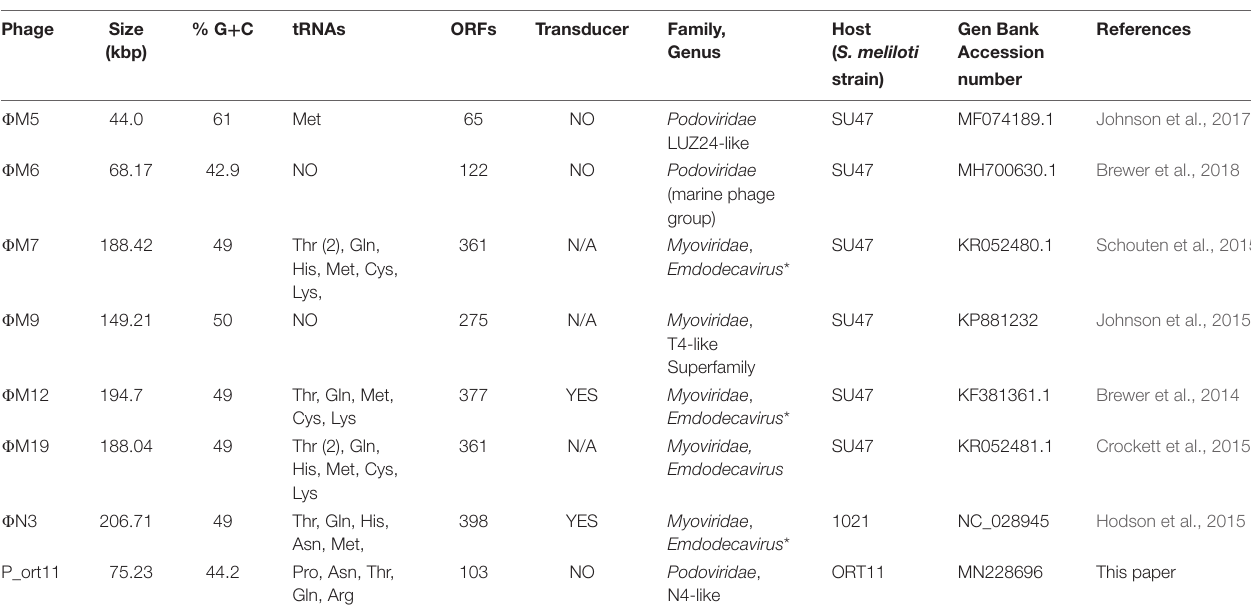
FIGURE 5 | Phylogenetic analysis of vRNAP (A) and terminase large subunit (B) proteins of P_ort11 compared to other N4-like phages. Neighbor-joining tree was constructed based on ClustalW (MEGA5). Bootstrap values ( > 50 %) are expressed as percentages of 1,000 replicates. Bar, 0.05 amino acid substitutions per site. TABLE 4 | Sinorhizobium meliloti lytic phages whose genome has been